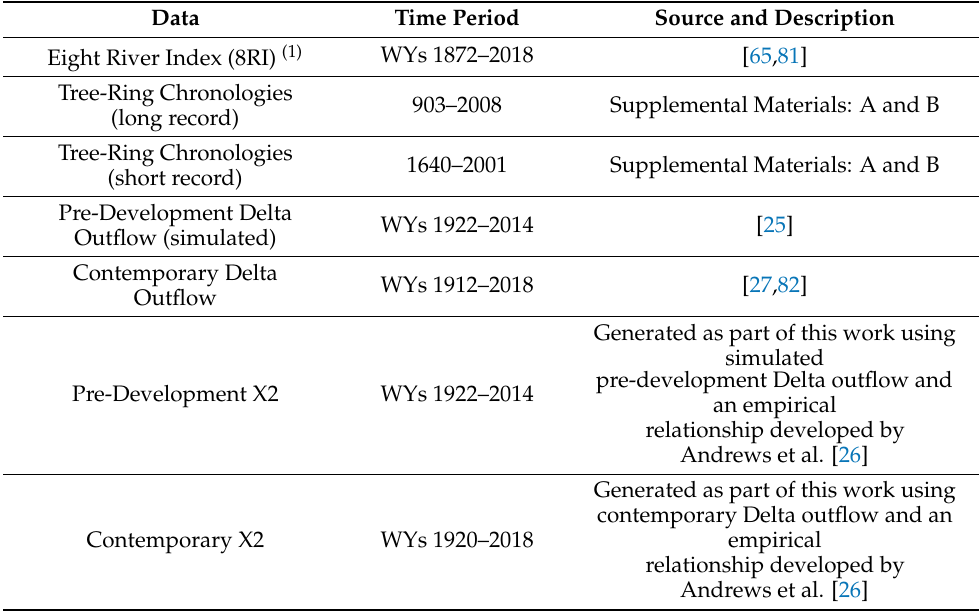
Table 1. Summary of model calibration and validation